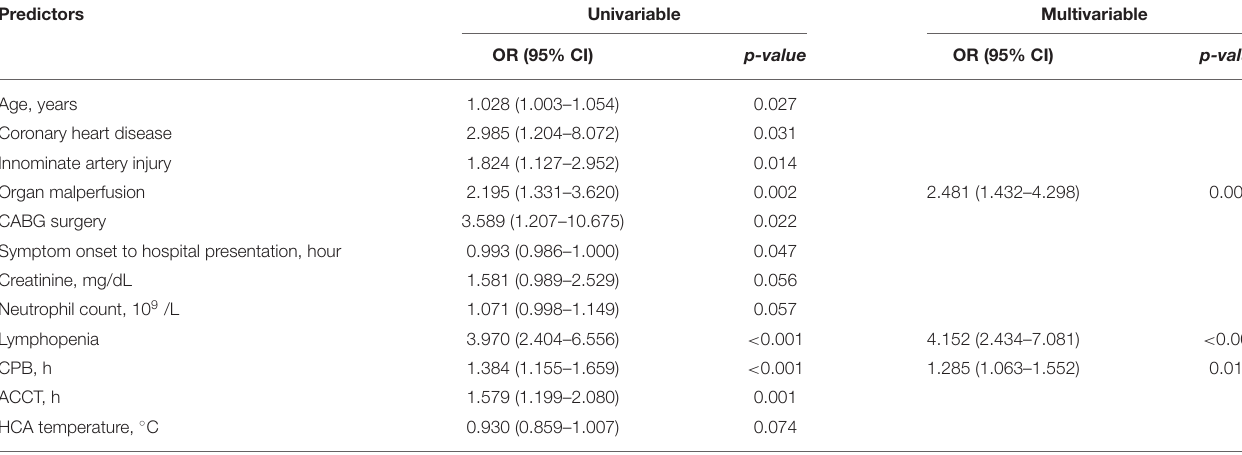
TABLE 4 | Univariable and multivariable logistic regression analysis of possible predictors of MAE.